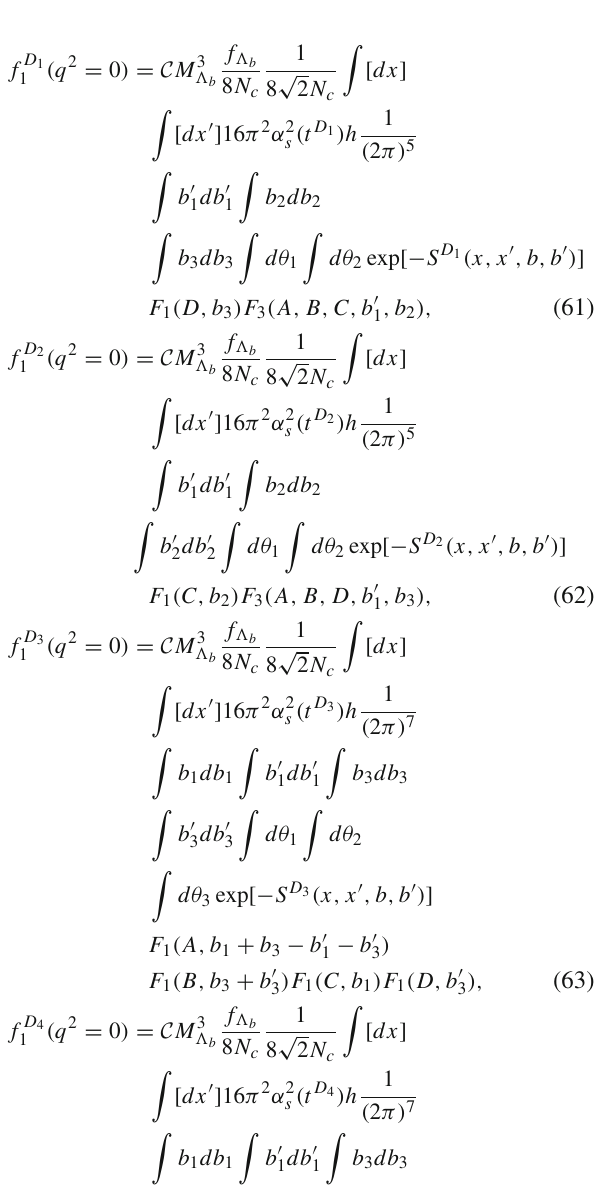
Fig. 1. Those for the other five form factors can be derived in a similar way. The last two diagrams with three-gluon vertices do not contribute due to the vanishing color